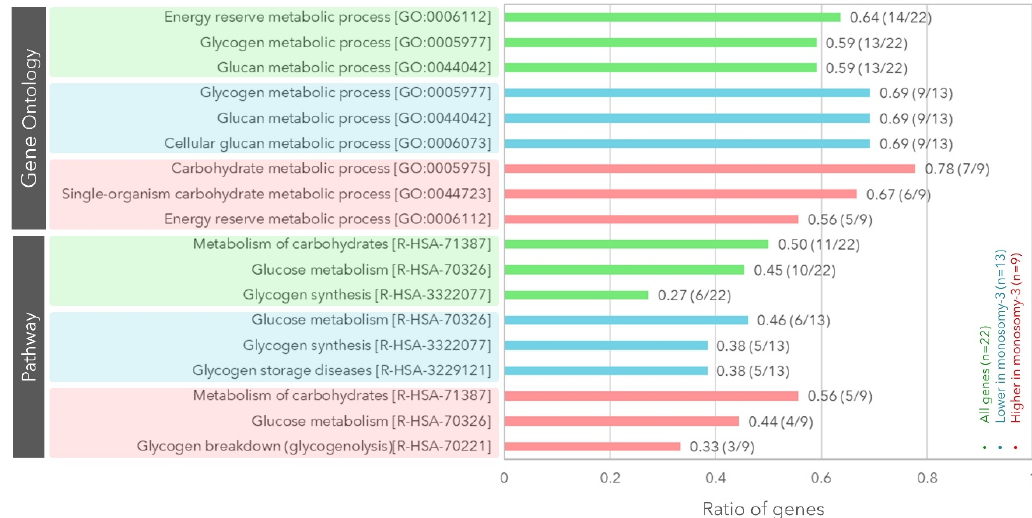
Figure 1. Gene set enrichment analysis demonstrating the gene ontology terms and biological pathways that were over-represented among the di ff erentially expressed genes in the monosomy-3 tumors. The di ff erentially expressed genes ( n = 22) are collectively presented in green, whereas the down- and up-regulated genes in the monosomy-3 tumors are indicated in blue vs. red, respectively. The y -axis lists the Gene Ontology terms and Reactome pathways that were most enriched among the subgroups of genes, while the x -axis represents the ratio of genes within a subgroup that were mapping to these functional classifications. The ratio and number of genes are stated adjacent to the bar plots. The accession numbers for the Gene Ontology terms and Reactome pathways are indicated in square brackets. All the p -values and false discovery rates were <0.001.